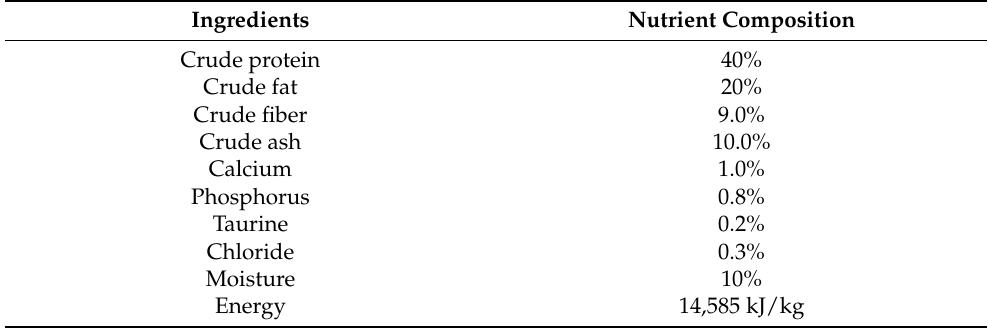
Table 1. Primary ingredients of the utilized diets.